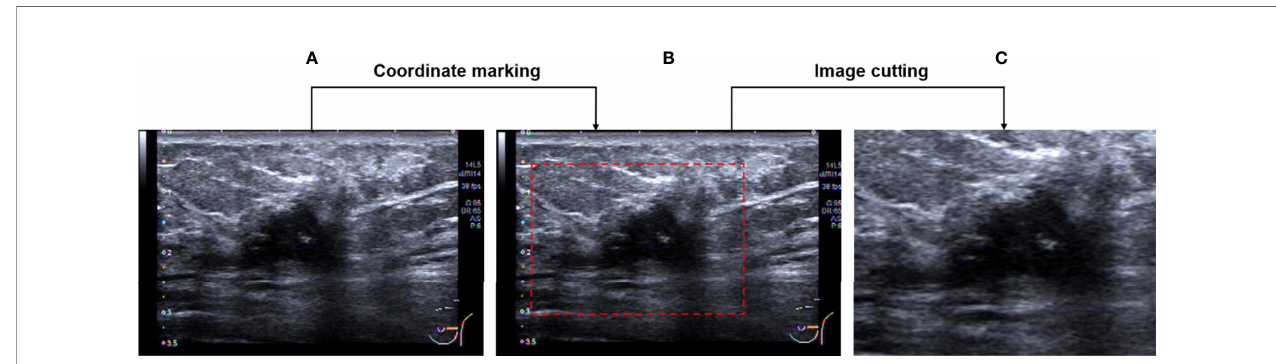
FIGURE 2 | Image pre-processing. (A) An original breast US image. (B) Image after coordinate marking. (C) The selected effective